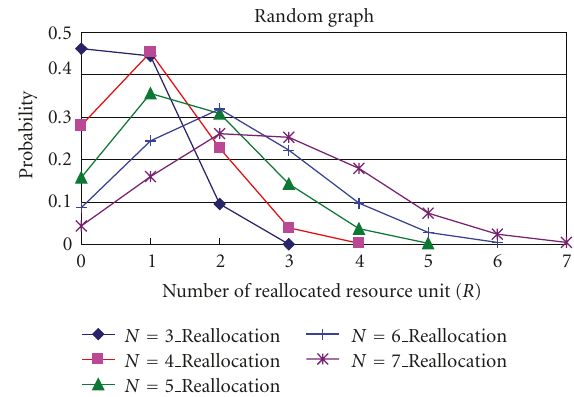
Figure 8: Probability density function of R : randomgraph scenario.